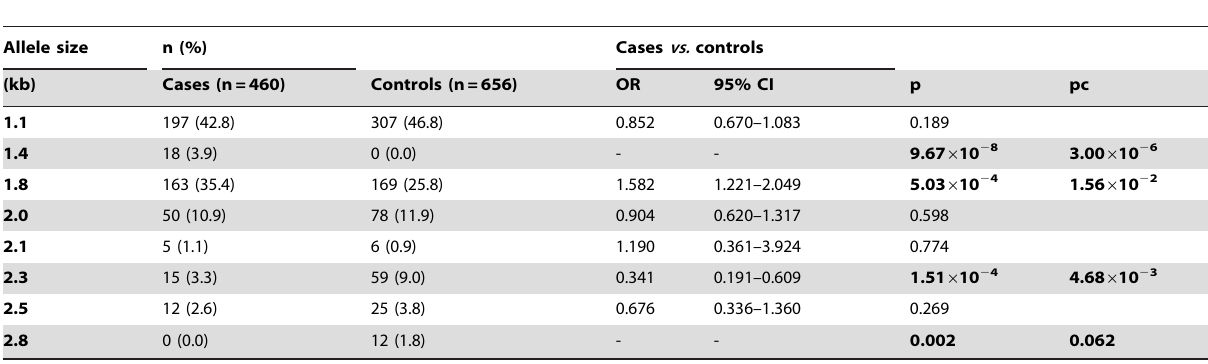
Table 1. Distribution of MUC5AC-u repetitive region alleles among cases and controls.